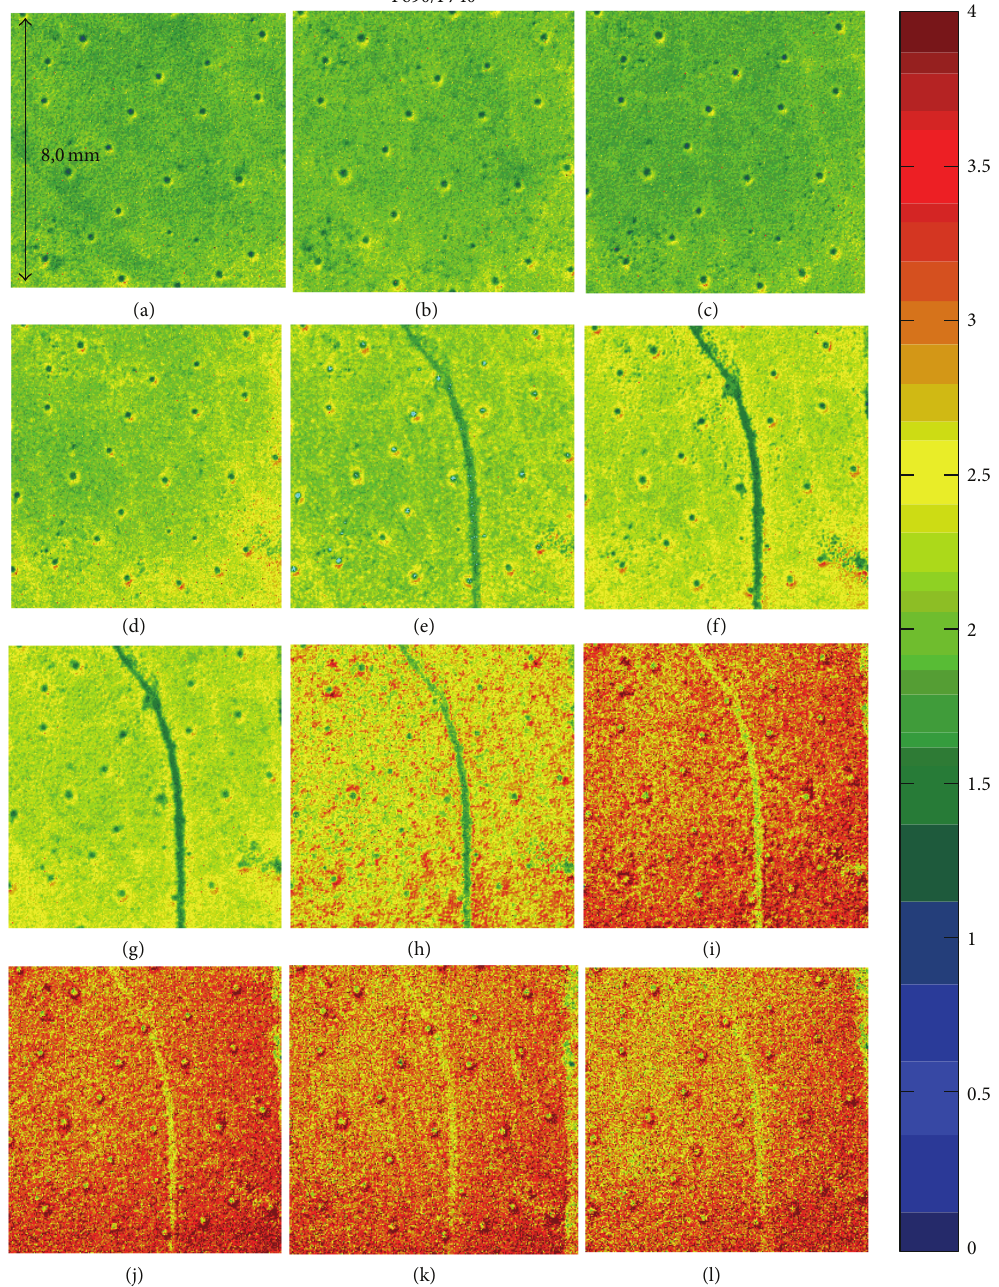
Figure 3: FMI 1 image as a function of detachment time (a) 0 days; (b) 1 day; (c) 2 days; (d) 3 days; (e) 4 days; (f) 5 days; (g) 6 days; (h) 7 days; (i) 8 days; (j) 9 days; (k) 10 days; (l) 11